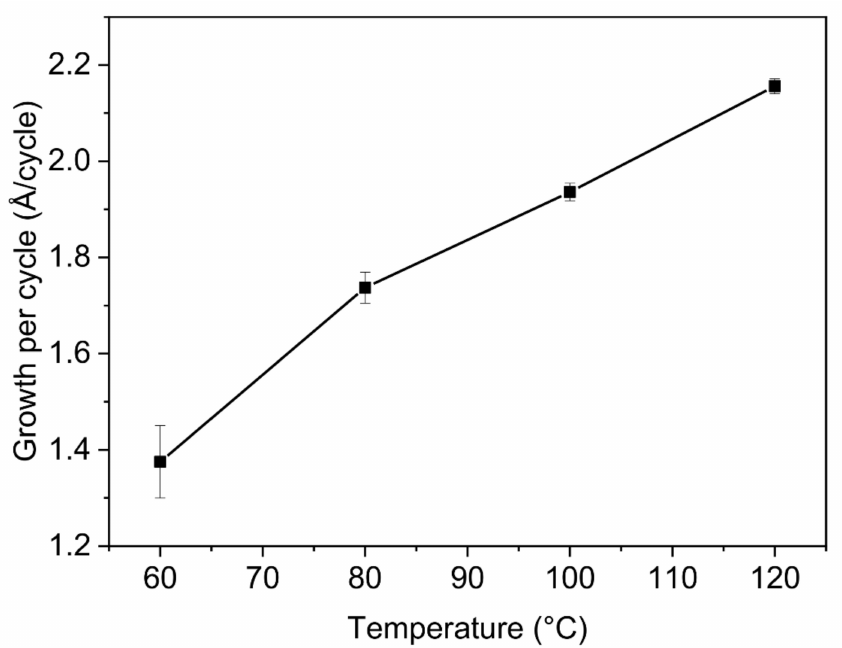
Figure 3. Growth rate per cycle (Å/cycle) of ZnO thin films by ALD for different deposition temperatures.